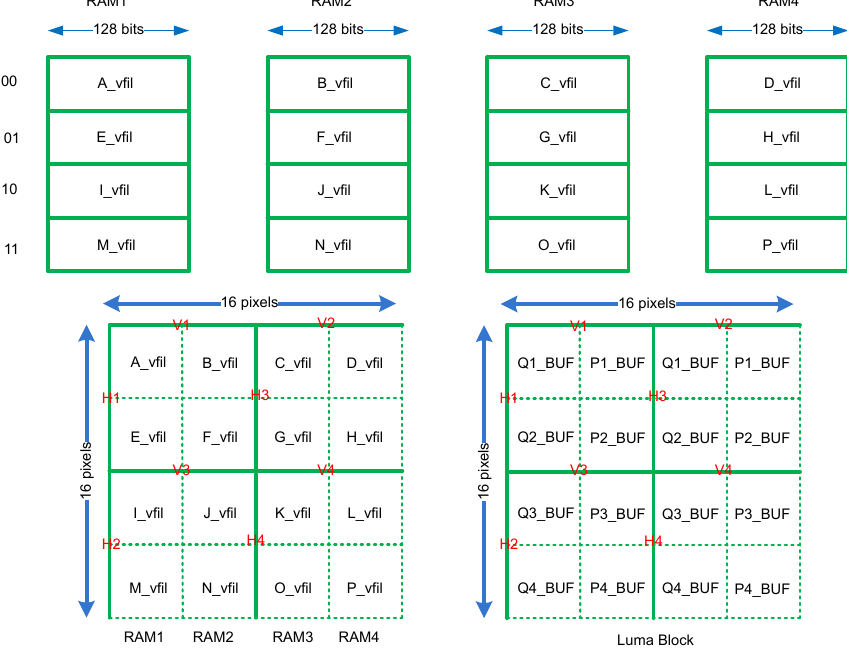
Figure 9. Mapping of internal memory to buffer before horizontal filtering for luma